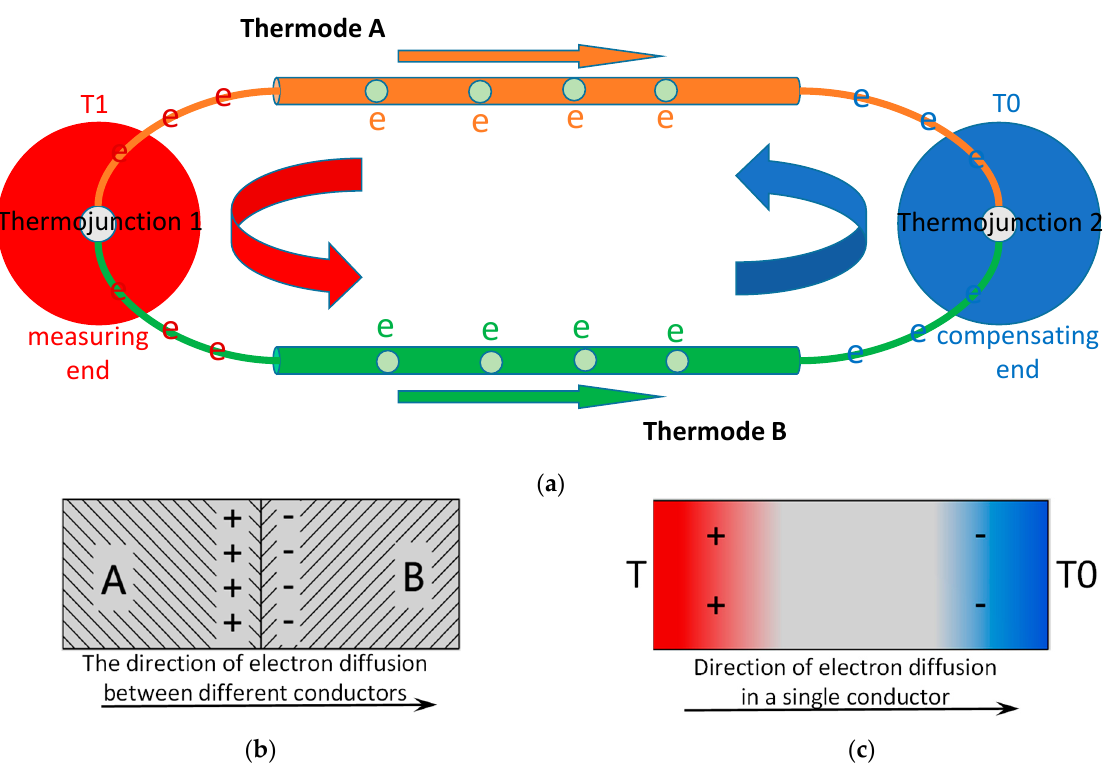
Figure 1. Working principle of thin-film thermocouple sensor: ( a ) Seebeck thermoelectric effect; ( b ) Peltier effect; ( c ) Thomson effect.